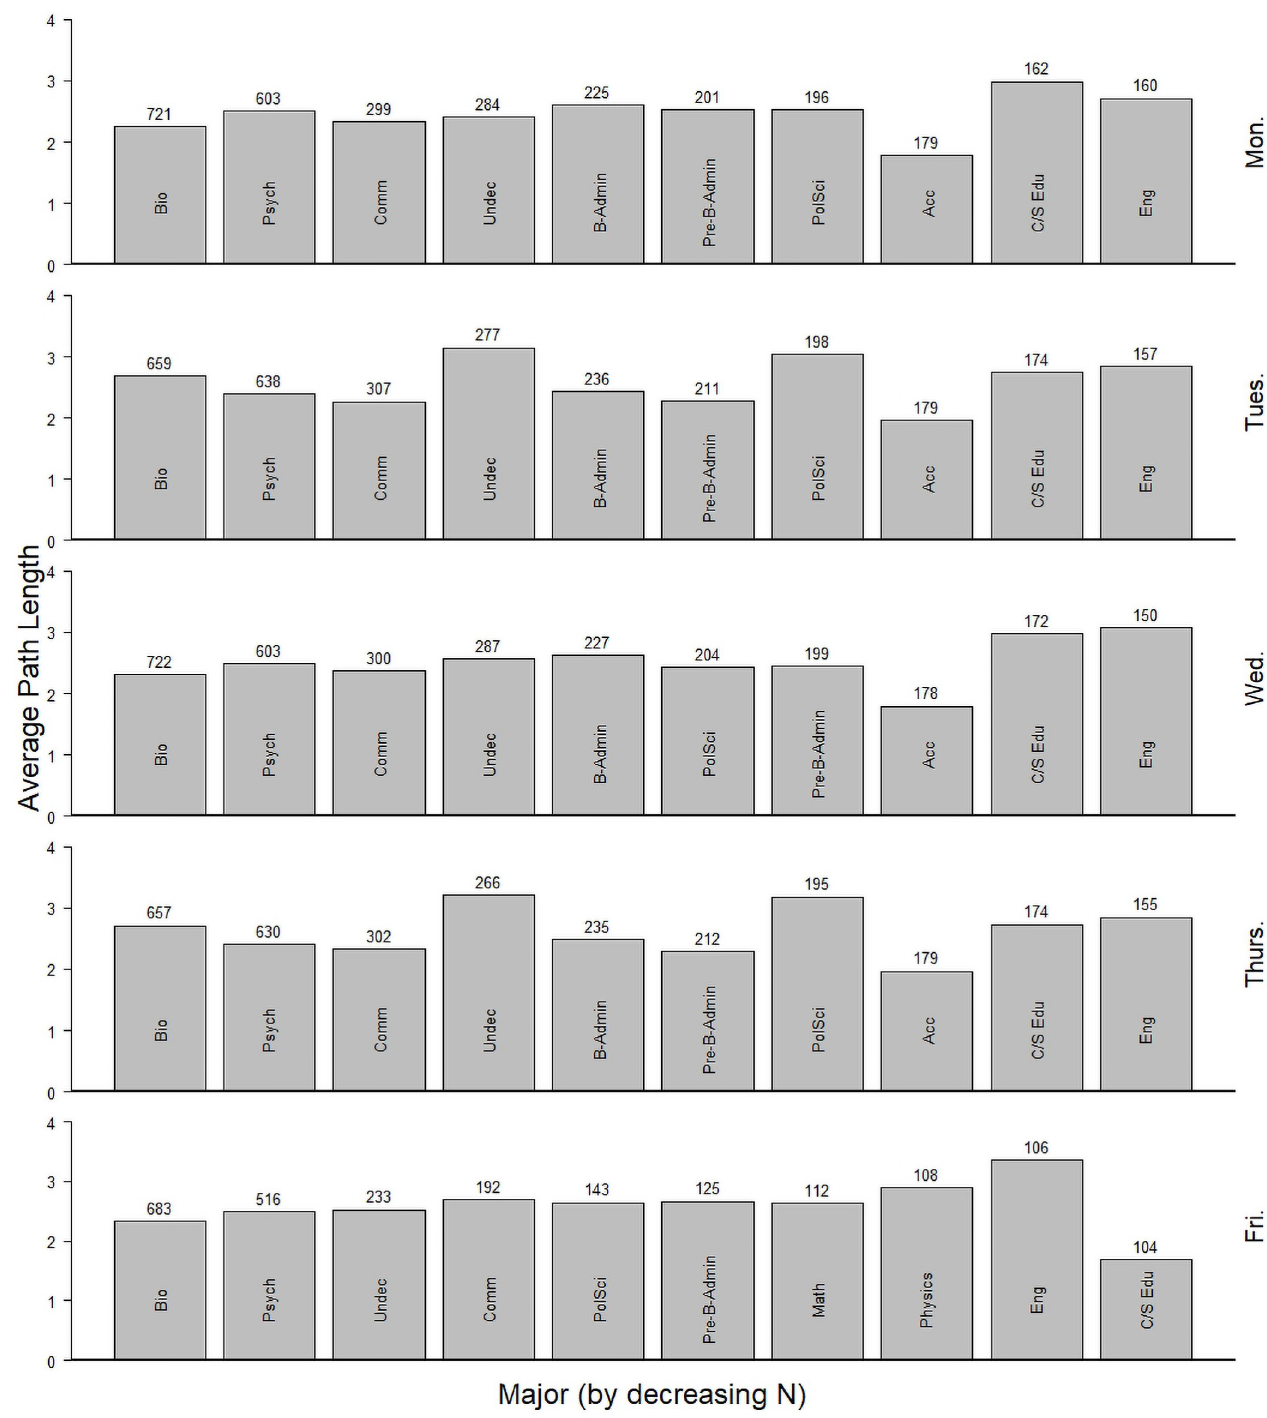
Fig 5. Average path length for students separated by major and weekday. The average path length (APL) for students in the 10 most populous majors for each weekday during the fall 2019 semester are shown. Numbers above bars represent the number of students registered in a class on that day by major. Abbreviations are: Biology (Bio), Psychology (Psych), Communications (Comm), Undecided (Undec), Political Science (PolSci), Business Administration (B-Admin), Pre-Business Administration (Pre-B-Admin), Accounting (Acc), Childhood/Special Education (C/S Edu), English (Eng), and Mathematics